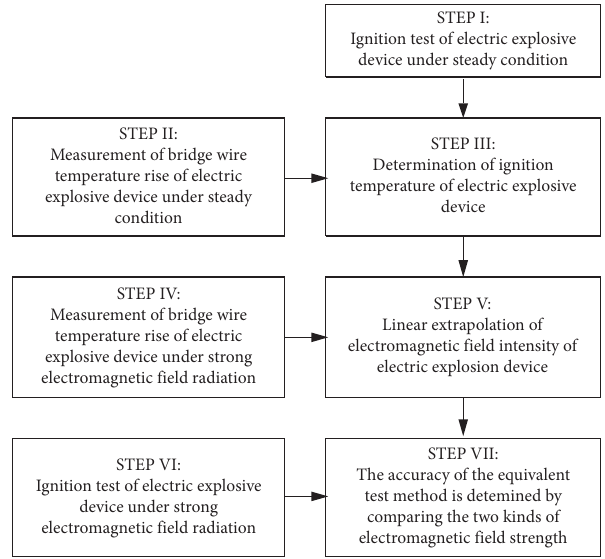
Figure 2: Test flowchart of the equivalent test method for strong field electromagnetic radiation effect.